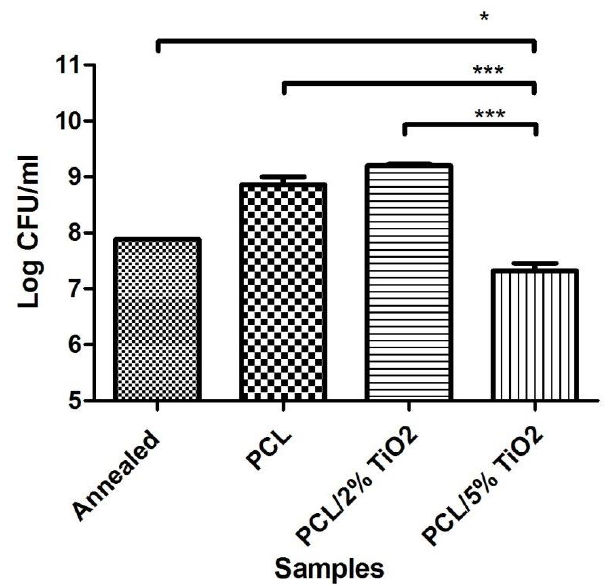
Figure 7. Antibacterial activity on different substrates against S.aureus .